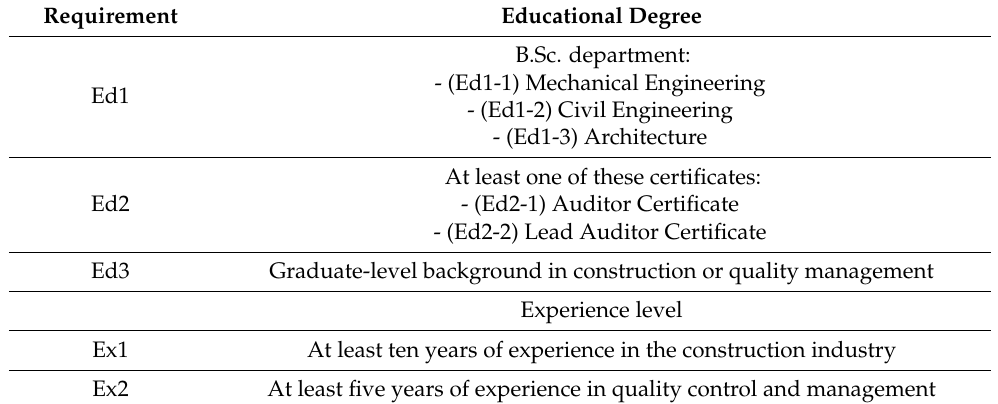
Table 2. Criteria for panelists [59].